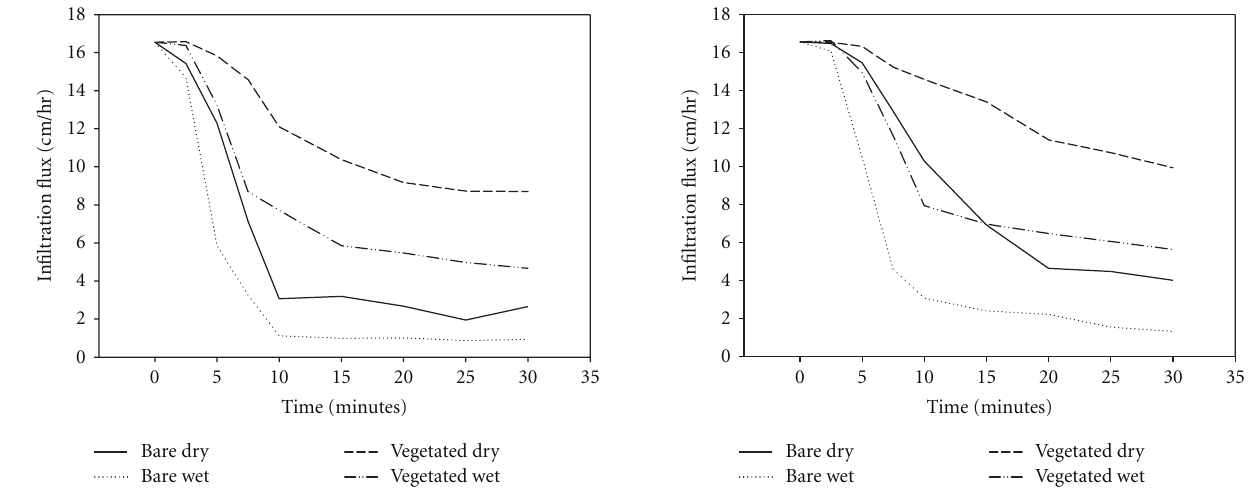
Figure 3: Infiltration flux for Stellar soil with 18Mg biosolidsha − 1 under bare dry, bare wet, vegetated dry, or vegetated wet conditions on the Sierra Blanca Ranch.